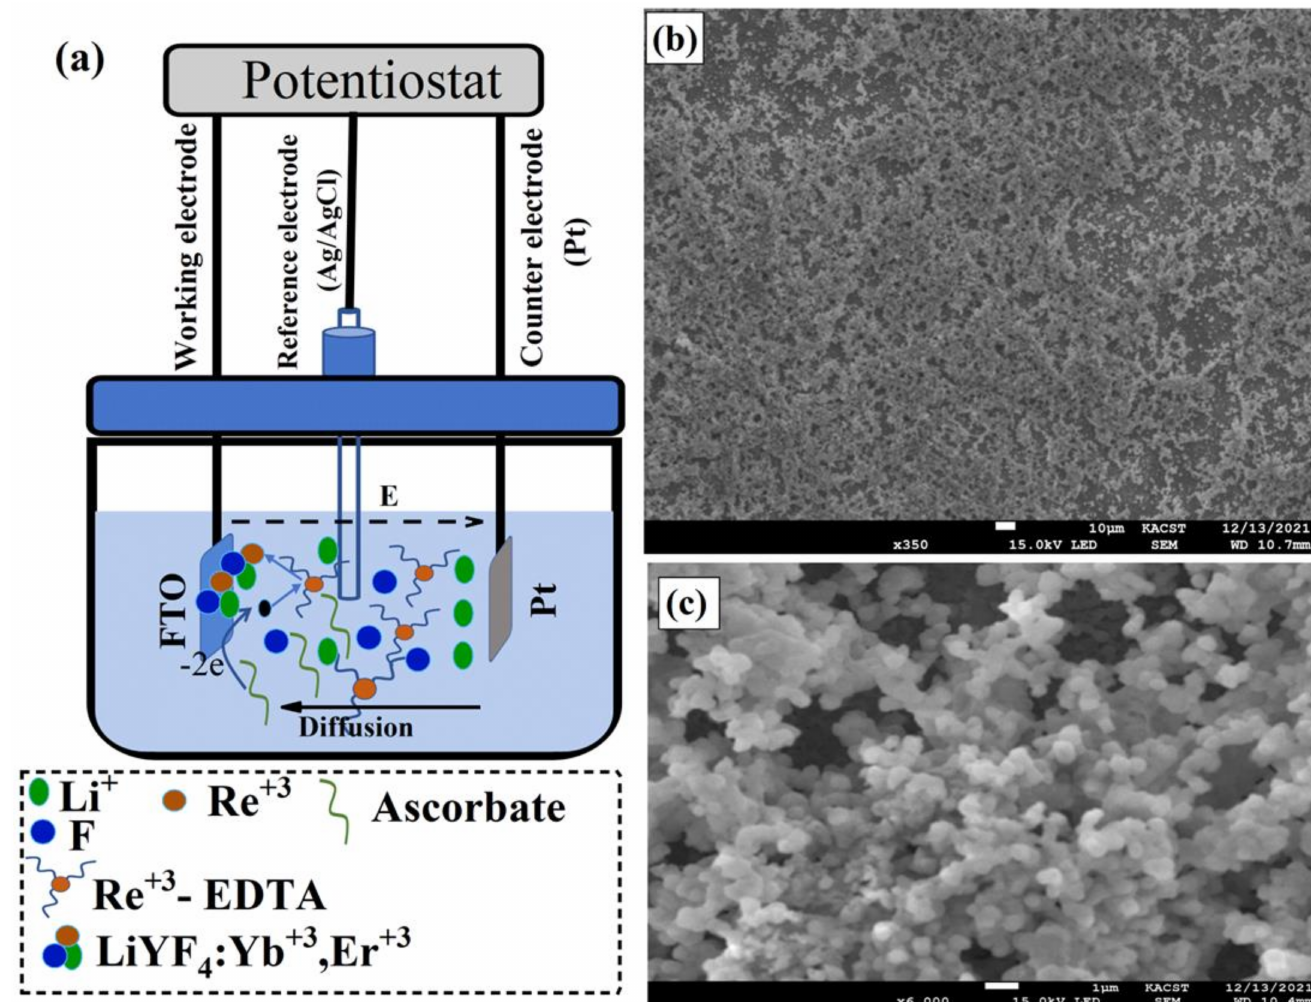
Figure 1. ( a ) Schematic illustration of lithium-based UC thin films, LiYF 4 : Yb, Er, electrodeposition process using Electrochemical Workstation. In the electrodeposition cells, a platinum plate (Pt) was used as a counter electrode, fluorine-doped tin oxide (FTO) glass as a working electrode, and an Ag/AgCl electrode as a reference electrode. Electrodeposition steps are also illustrated in Figure 1a where, Li + , Re 3 + , and Re 3 + -EDTA represents lithium ions, rare-earth elements, and rare-earth elements-EDTA complex, respectively. ( b , c ) Low- and high-magnification SEM images of LiYF 4 : Yb, Er films electrodeposited on FTO in aqueous solution at 70 ◦ C and annealed at 300 ◦ C for 6 h. The optical properties of the electrodeposited and annealed UC films were investi- gated. For this, we built a custom-made confocal laser-scanning microscope, equipped with continuous-wave (CW) 980 nm (NIR) lasers, an optical spectrometer, and a single-photon counter, as illustrated in Figure 2b. Under a relatively low intensity NIR laser excitation (20 W · cm − 2 ), the UC films revealed a strong UC visible emission consisting of strong and sharp green peaks and relatively weak red peaks, as illustrated in Figure 2c. These emission peaks are the characteristic transitions of the Er 3 + ion according to the following opti- cal transitions: 2 H 11/2 → 4 I 15/2 (525 nm), 4 S 3/2 → 4 I 15/2 (555 nm) and 4 F 9/2 → 4 I 15/2 (654 nm), as illustrated in Figure 2d